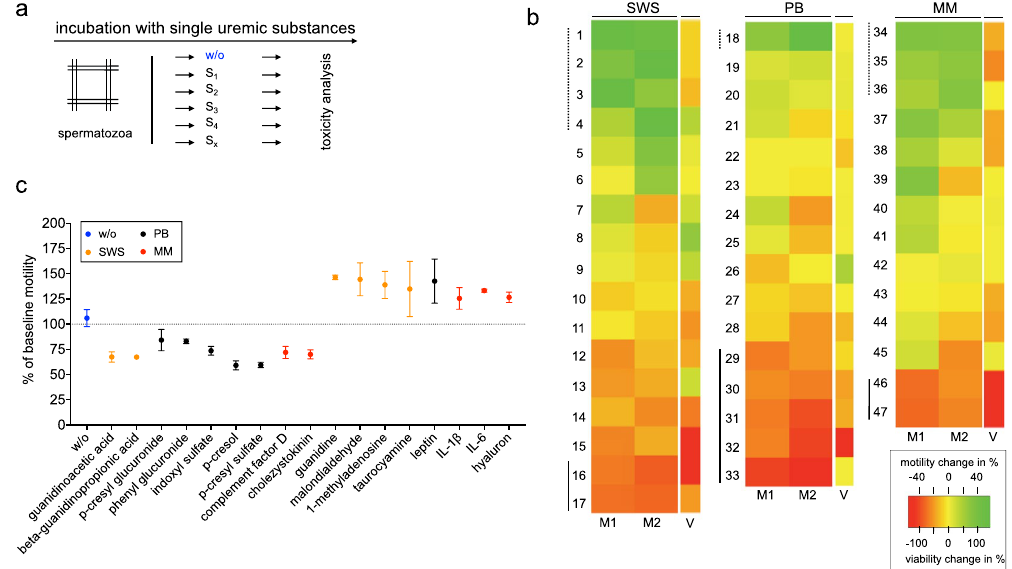
Figure 4. Toxicity detection of denominated uremic toxins (UT). (a) Workflow to measure effects of single substances (S 1 -S x ) . (b) 47 UT tested for influence on motility (after 90 minutes of incubation) and survival (after 300 minutes of incubation). UT are assigned to the three bio-chemical classes (small water-soluble compounds (SWS), protein bound (PB), middle molecules (MM)). Data are shown as relative change to non-toxic control. M1 and M2 represent two separate experimental motility rounds, V represents mean viability of six experimental rounds. Bold lines mark UT with reduced motility < 25%, dashed lines mark UT with increased motility > 25%. Marked UT are displayed in (c) . Left: all UT with toxic effect, right: all UT with non-toxic effect. At least two separate experimental rounds are shown. Incubation was performed for 90